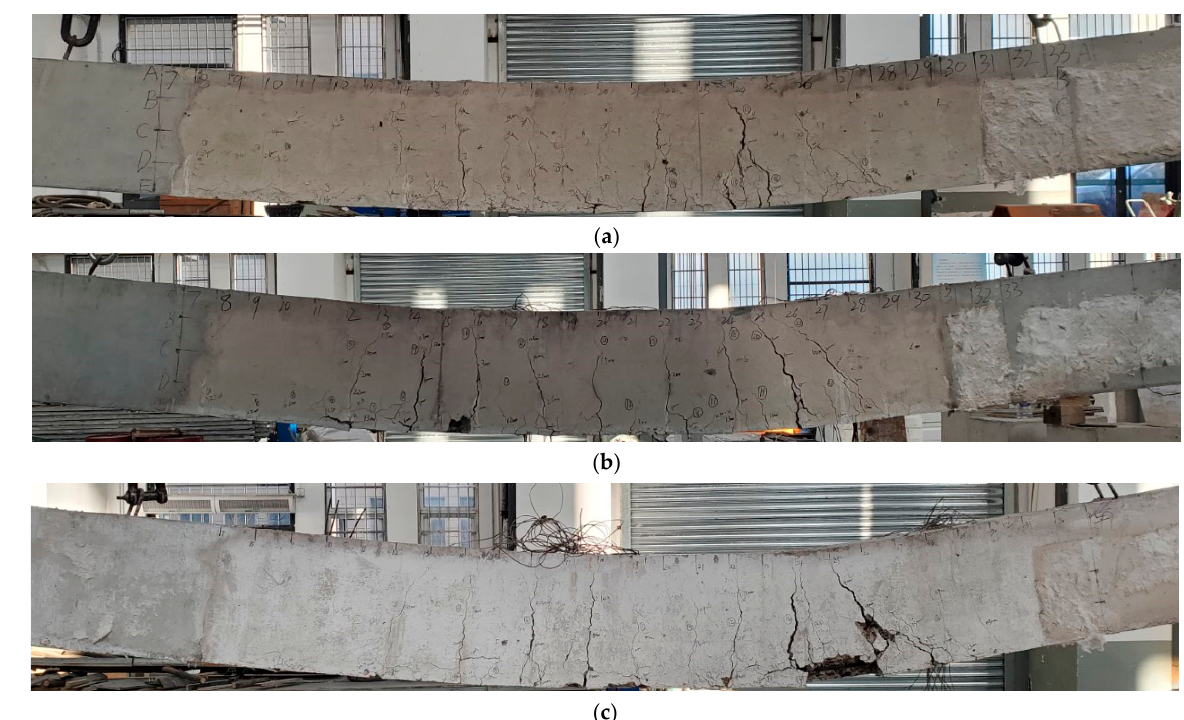
Figure 7. Failure modes of SSB under fire: ( a ) SSB-1; ( b ) SSB-2; ( c ) SSB-3.